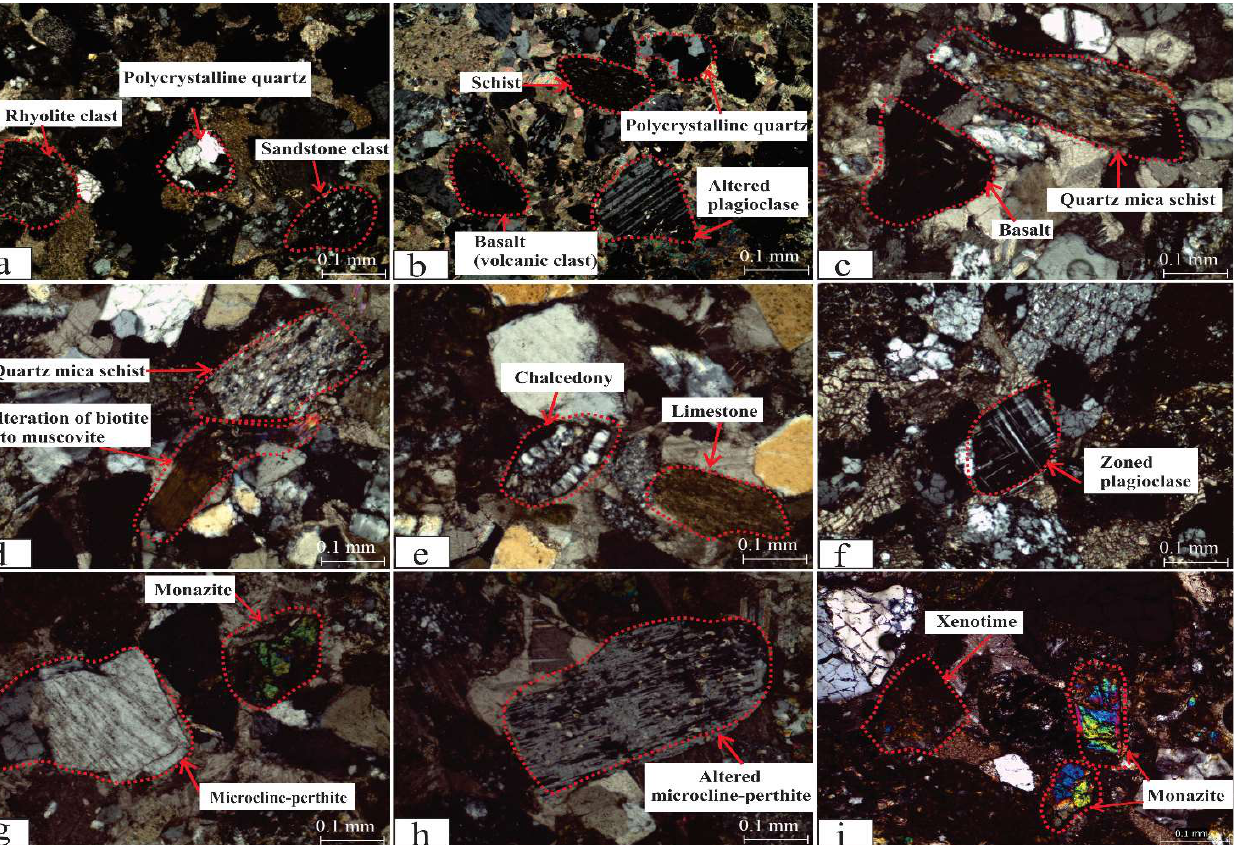
Figure 8. Photomicrographs showing ( a ) volcanic (rhyolite), polycrystalline quartz and sandstone clast, ( b ) polycrystalline quartz, schist, volcanic (basalt) clast and altered plagioclase, ( c ) basalt and quartz-mica schist, ( d ) quartz-mica schist and alteration of biotite into muscovite, ( e ) chalcedony and limestone clast, ( f ) zoned plagioclase, ( g ) microcline perthite and monazite, ( h ) altered microcline perthite, and ( i ) monazite and xenotime.